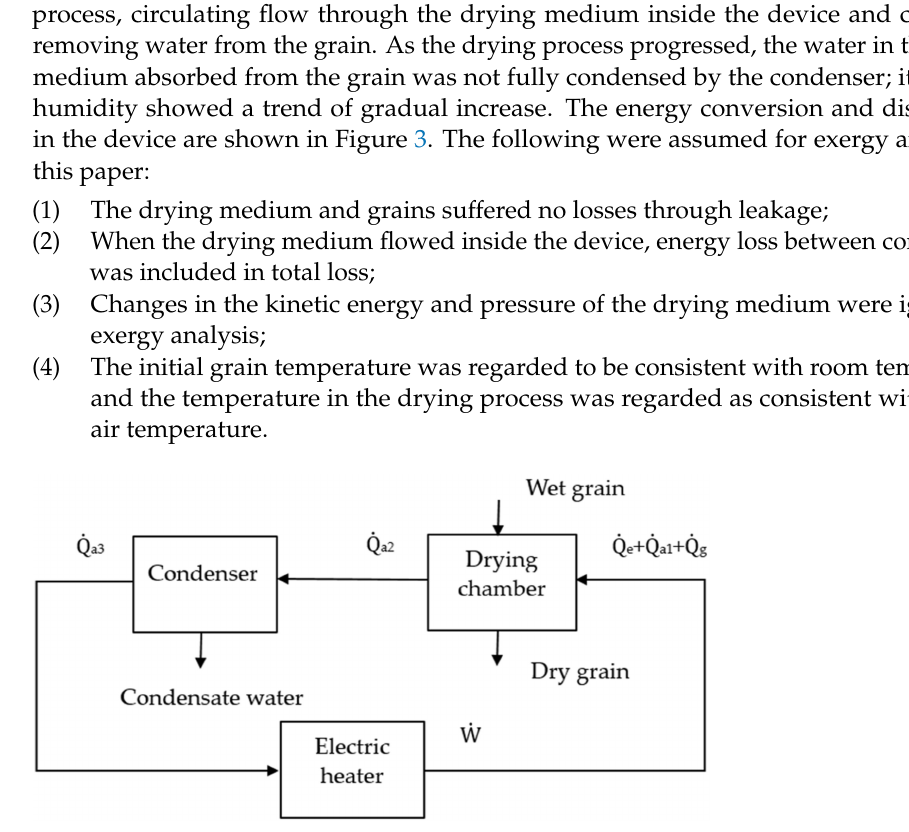
Figure 3. Energy flow diagram of the experimental